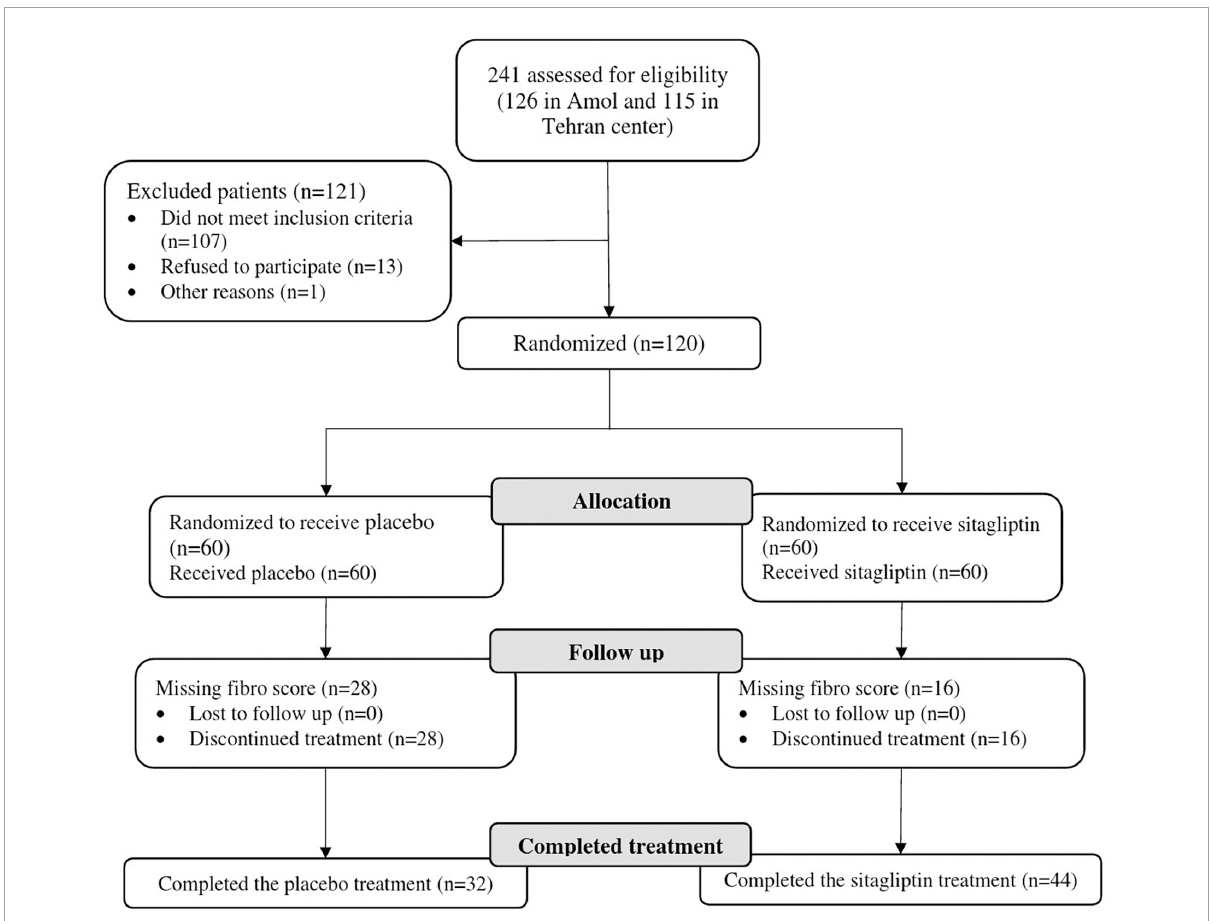
FIGURE1 Participants’ CONSORT